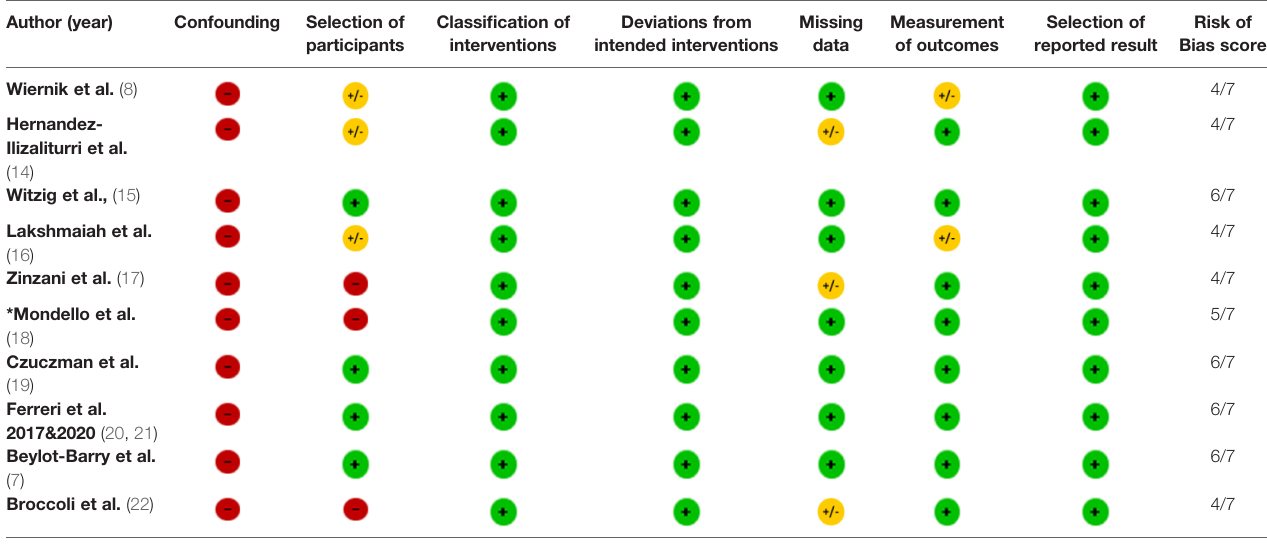
TABLE 2 | Results from the risk of bias in non-randomized studies of interventions (ROBIN-I)